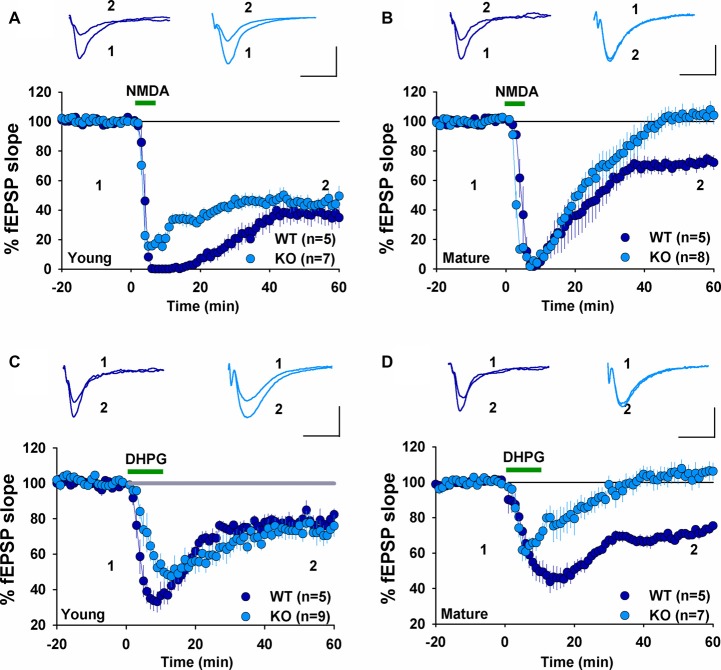
fEPSP recordings showing chemically induced LTD in young, but not mature GluA2 KO mice. (A) NMDA (25 μM, 3 min) induces LTD in both young WT and GluA2 KO mice. (B) NMDA (25 μM, 3 min) induces LTD in mature WT but not in mature GluA2 KO mice. (C) DHPG (100 μM, 10 min) induces LTD in both young WT and GluA2 KO mice. (D) DHPG (100 μM, 10 min) induces LTD in mature WT but not in mature GluA2 KO mice.